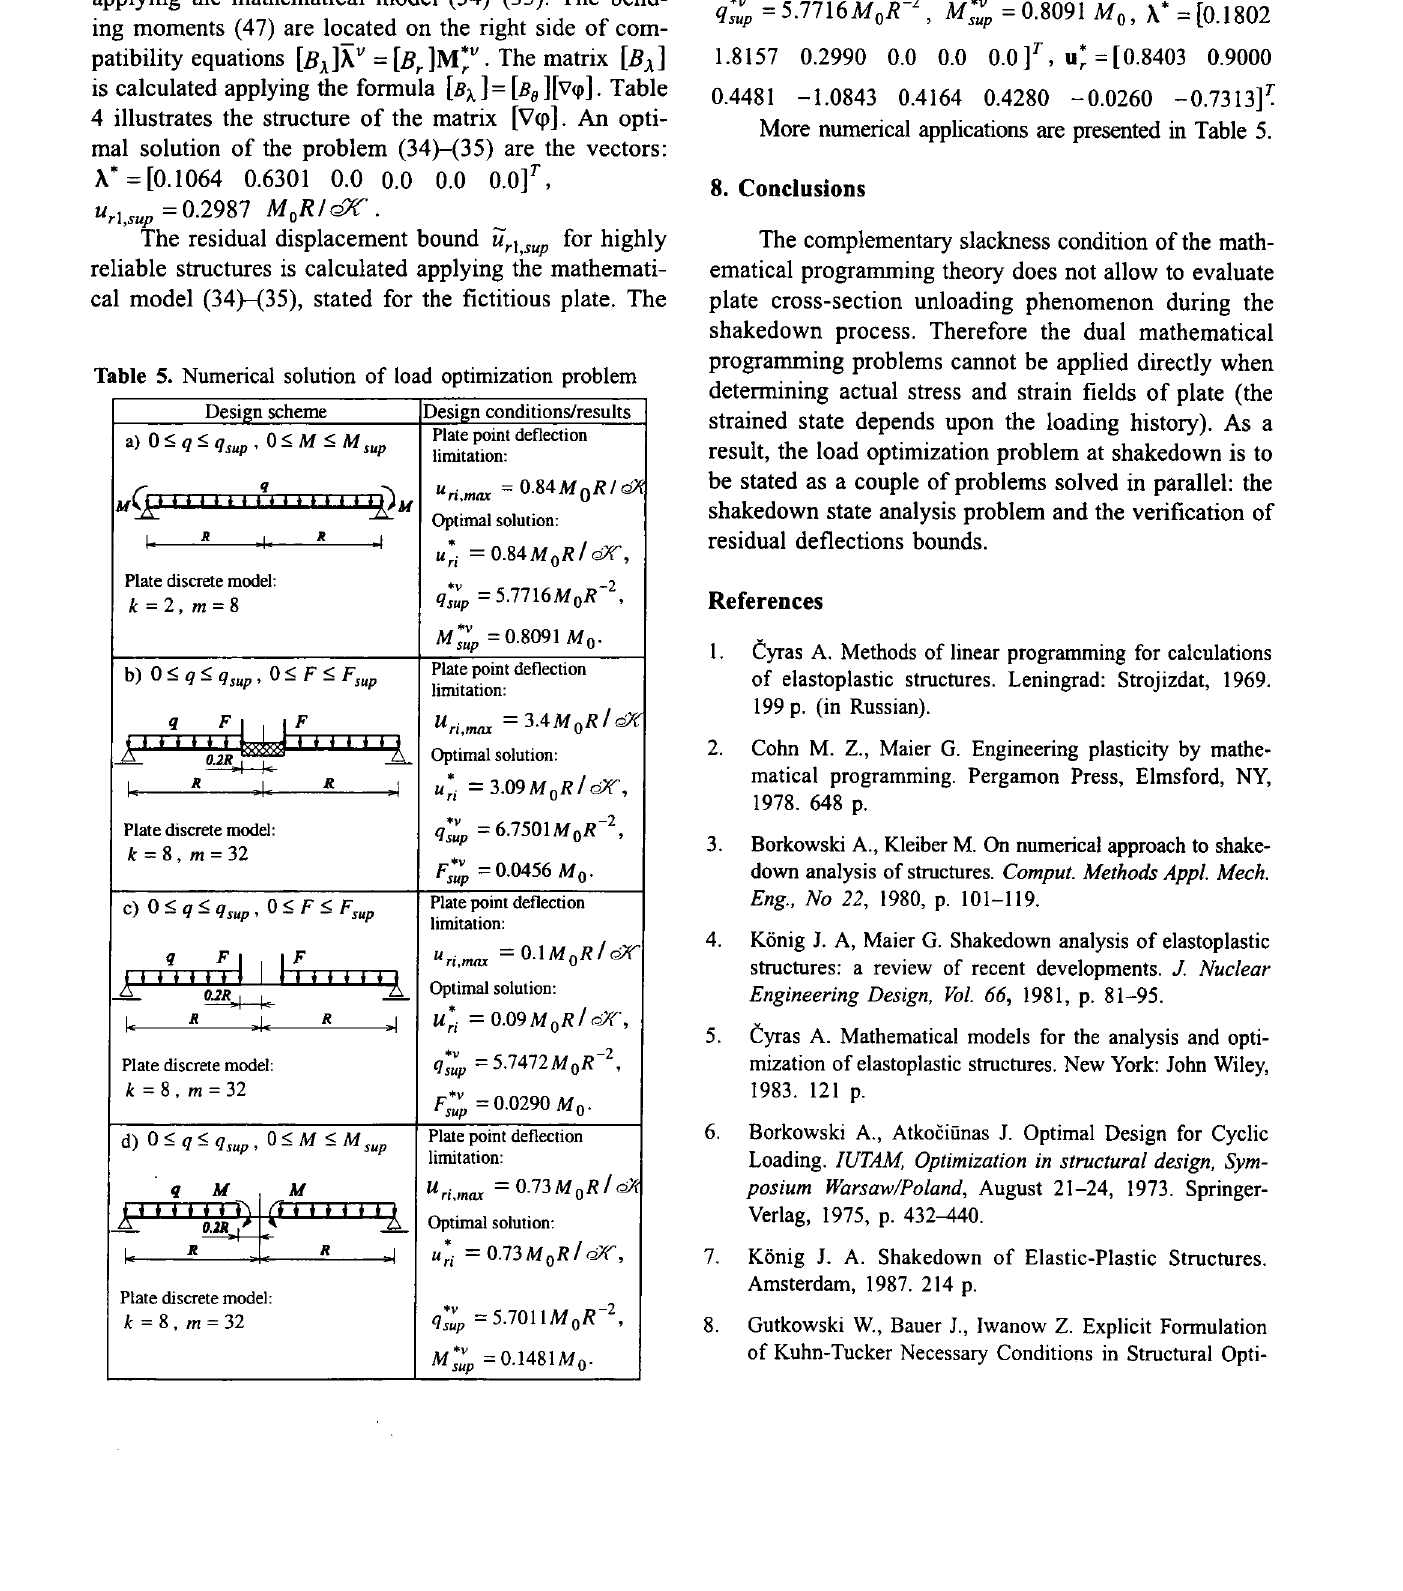
Table 5. Numerical solution of load optimization problem Desi2n scheme Design